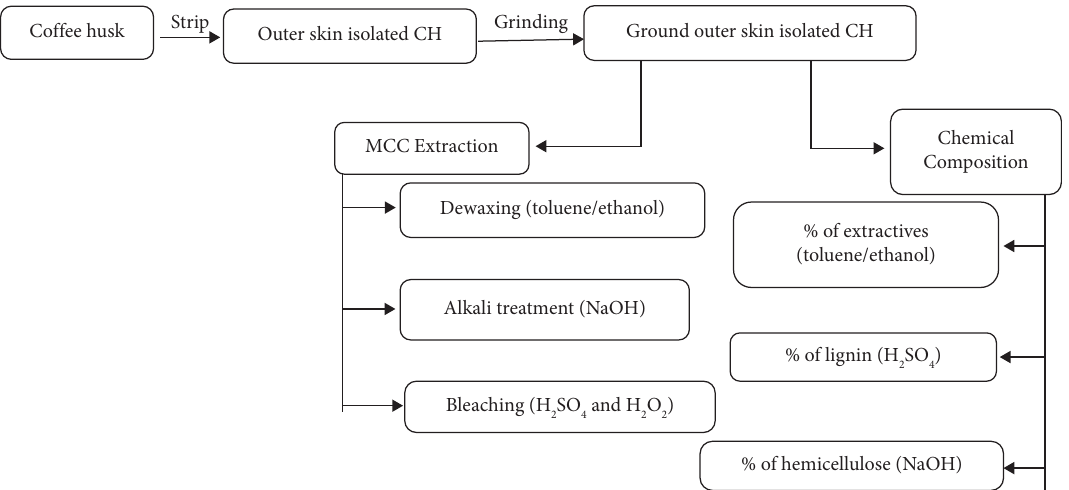
Figure 2: Schematic diagram of MCC extraction and chemical composition of outer skin-isolated cofee